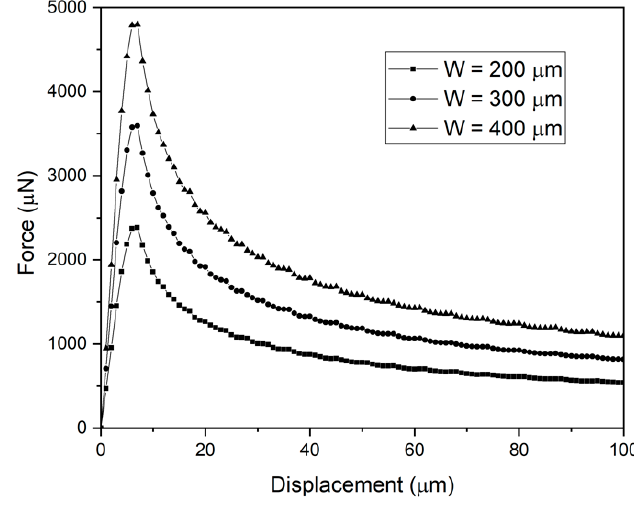
Figure 10. Three-dimensional Finite Element Method (FEM) model for Cohesive Zone model (CZM) interface delamination. Table 4. Cohesive Zone model (CZM) parameters.